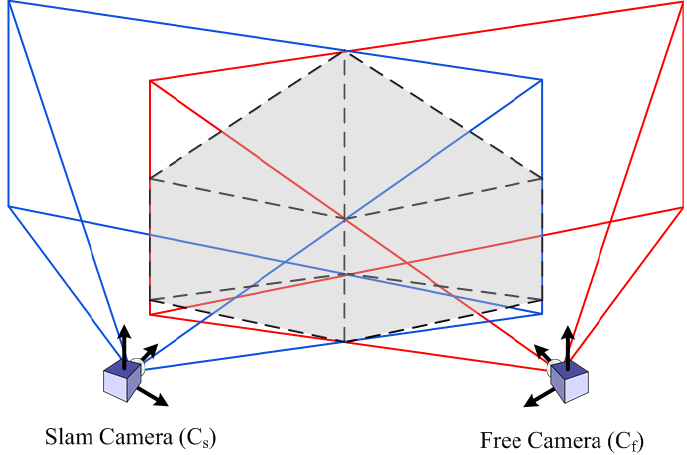
Figure 6. Polyhedron found intersecting fields of view until a depth where minimum parallax pl could be min